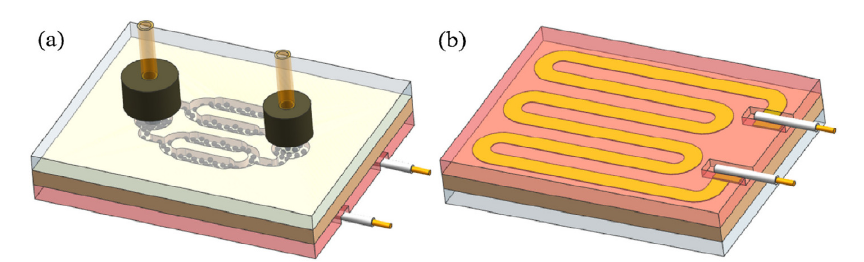
Figure 2. Schematic depiction of the metal gas preconcentrator. ( a ) Structure from the top view, ( b ) the ceramic heater from the backside view. Reprinted with the permission of Elsevier from